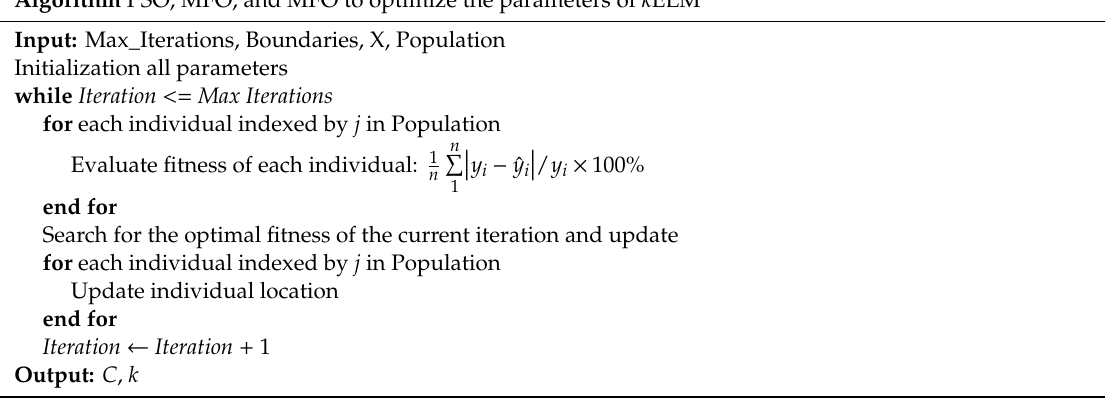
Table 2. The pseudocode of multiverse optimizer (MVO), particle swarm optimization (PSO), and moth–flame optimization (MFO) to optimize the parameters of kELM. Algorithm PSO, MFO, and MFO to optimize the parameters of k